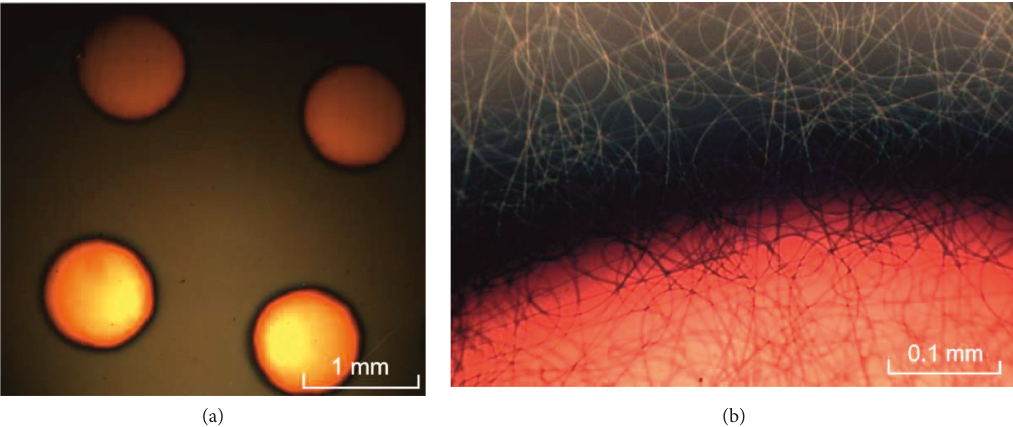
F IGURE 1: Nanofiber matrices on the Si-SiO 2 substrate with deposited Au contacts. Photos made with an optical microscope at magnification 4x (a) and 40x (b).